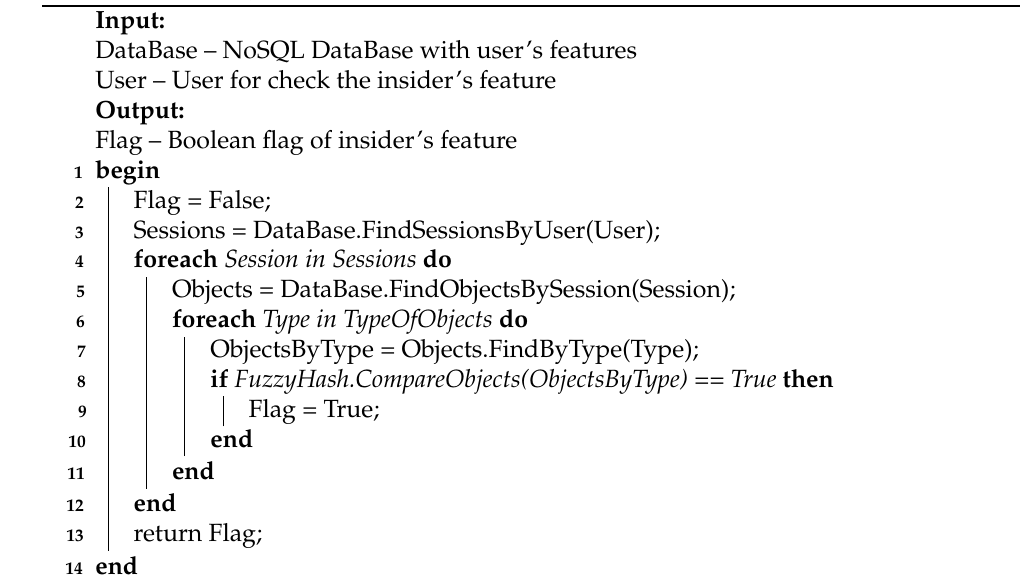
Algorithm 7: Algorithm for Feature